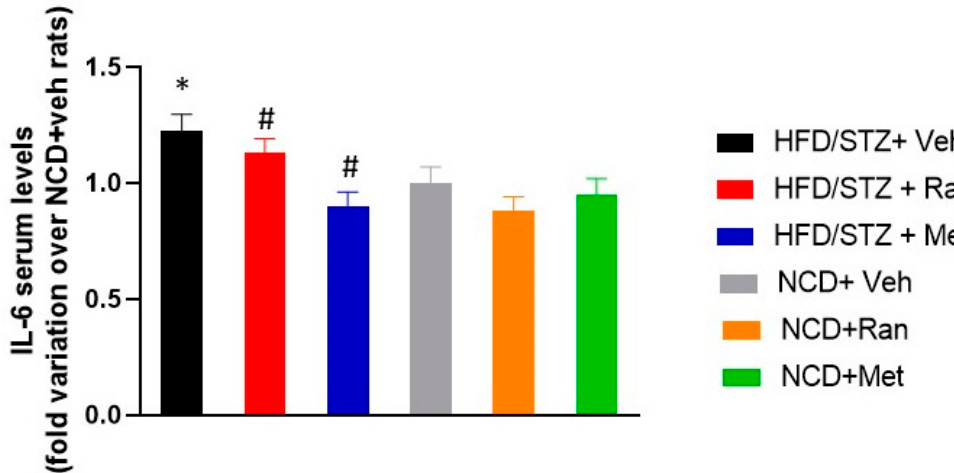
Figure 4. IL-6 serum levels in each experimental group. Data values are mean ± SD and are expressed as fold variation over NCD + Vehicle rats. * p < 0.05 significantly different from NCD + Vehicle group. # p<0.05 significantly different from HFD/STZ + Vehicle group by two-way ANOVA with Tukey’ s post hoc test. HFD = High fat diet; NCD = Normocaloric diet; STZ = Streptozotocin; Veh = Vehicle; Ran = Ranolazine; Met = Metformin.